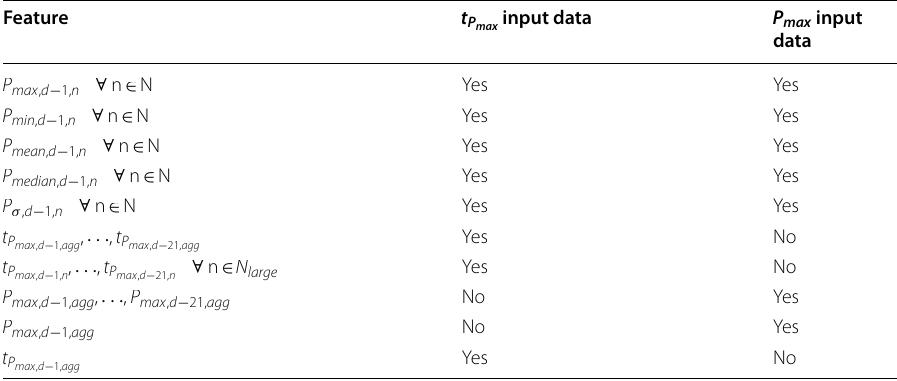
Table 2 Features for XGBoost datasets for peak load P max and peak time t P day d , based on values from previous day ( d − 1 ) or previous days. Features are either based on the aggregated energy community load ( agg ) or smart meter data of households